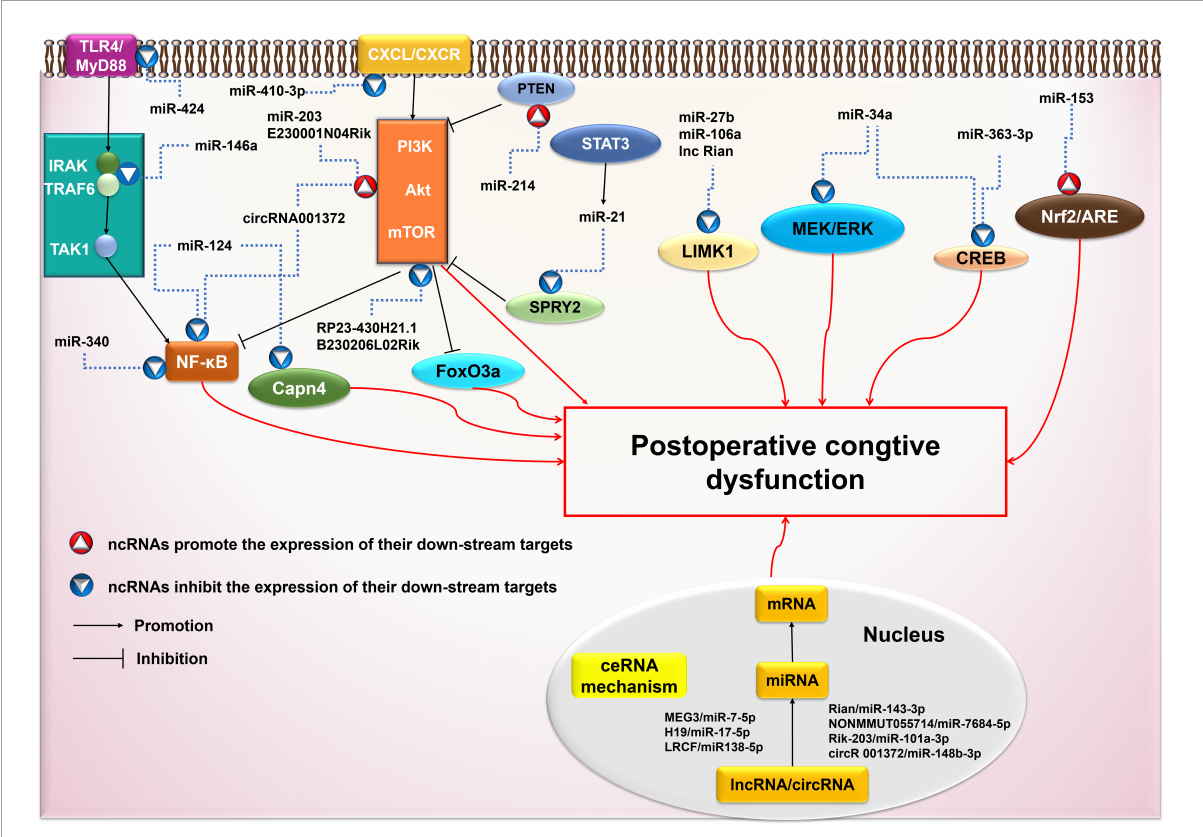
FIGURE3 Possible ncRNAs-mediated signaling pathways in postoperative cognitive dysfunction (POCD). AKT, protein kinase B; ARE, antioxidant response element; circRNA: circular RNA; CREB, cAMP-response element binding protein; CXCR4, chemokine CXC receptor 4; ERK, extracellular signal-regulated kinase; FoxO3a, forkhead box O 3a; IRAK, IL-1 receptor-associated kinase; LIMK1, LIM kinase 1; lncRNA: long non-coding RNA; MAPK, mitogen activated protein kinase; miRNA: microRNA; mRNA: messenger RNA; mTOR, mammalian target of rapamycin; MyD88, myeloid differentiation factor 88; ncRNA: non-coding RNA; NF- κ B, Nuclear Factor κ B; Nrf2, nuclear factor-erythroid 2-related factor 2; PI3K, phosphatidylinositol 3 -kinase; SPRY2, Sprouty 2; STAT3, activated Signal Transducer and Activator of transcription 3; TAK1, TGF β -activated kinase 1; TGF, transforming growth factor; TLR, toll-like receptor; TNF, tumor necrosis factor; TRAF6, TNF receptor-associated factor